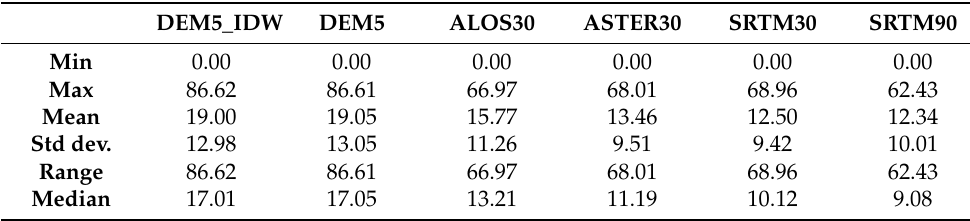
Table 6. The descriptive statistics of the slope values ( ◦ ) for all DEM. DEM5_IDW DEM5 ALOS30 ASTER30